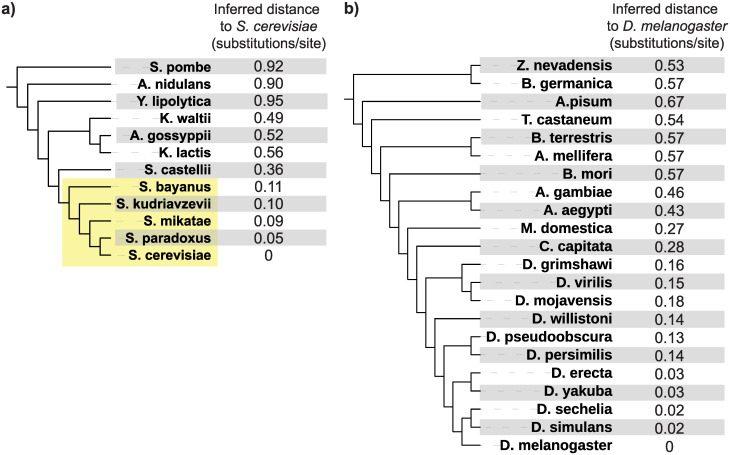
Inferred evolutionary distances between each fungal species and S. cerevisiae (a) and each insect species and D. melanogaster (b).The tree topologies for these taxa are based on previously published studies [34, 35] and were not calculated here; branch lengths are not to scale. The fungal sensu stricto lineage, referenced frequently in the text, is shaded in yellow.